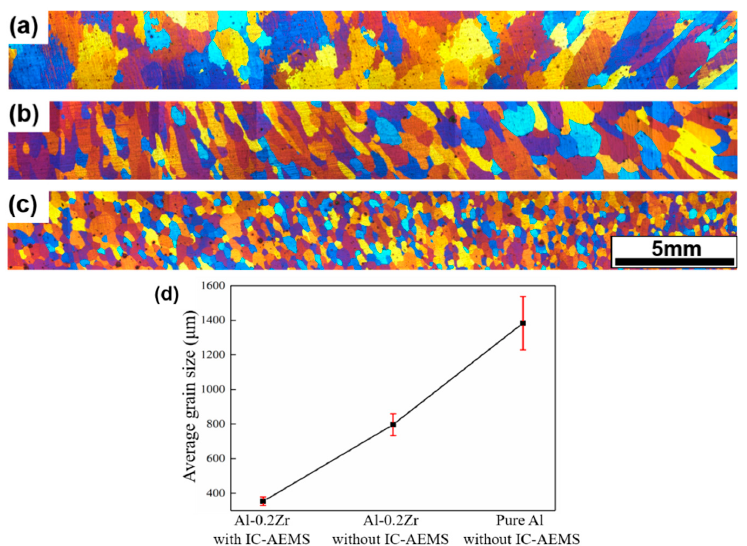
Figure 3. Macrographs showing the grain structures of Al and Al-0.2%Zr poured at 720 ◦ C and solidified in the TP-1 mold (3.5 ◦ C/s). ( a ) Pure Al without IC-AEMS; ( b ) Al-0.2%Zr without IC-AEMS; ( c ) Al-0.2%Zr with IC-AEMS; and ( d ) measured average grain